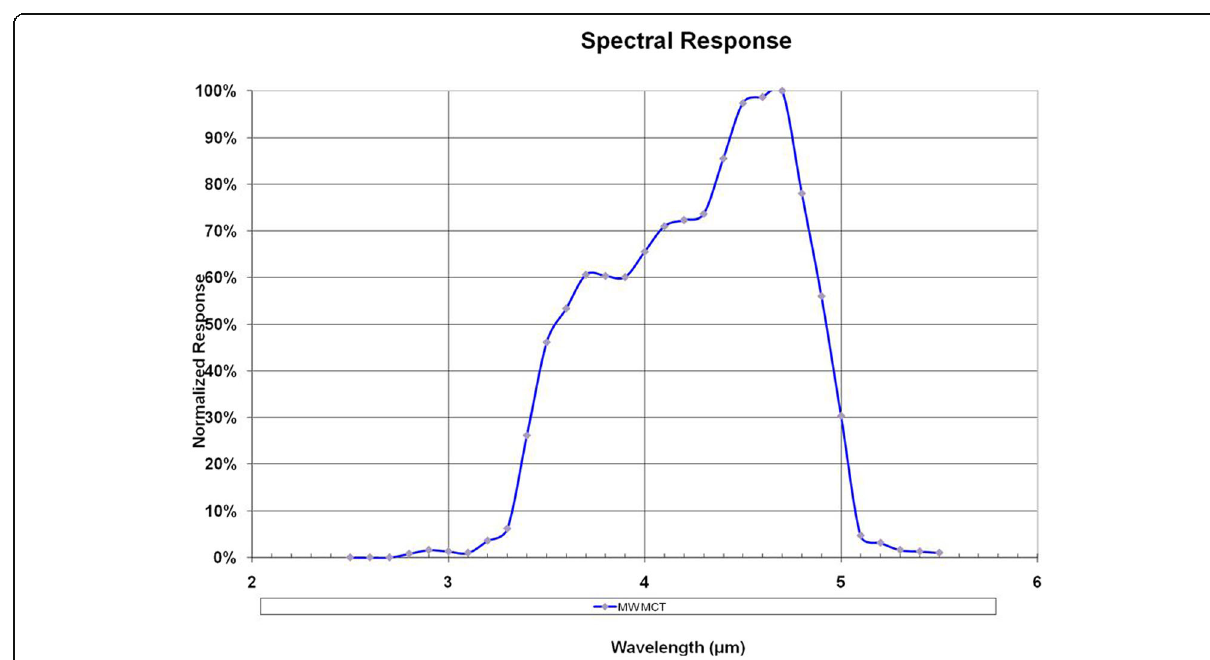
Fig. 2 Spectral response curve of medium wave detector